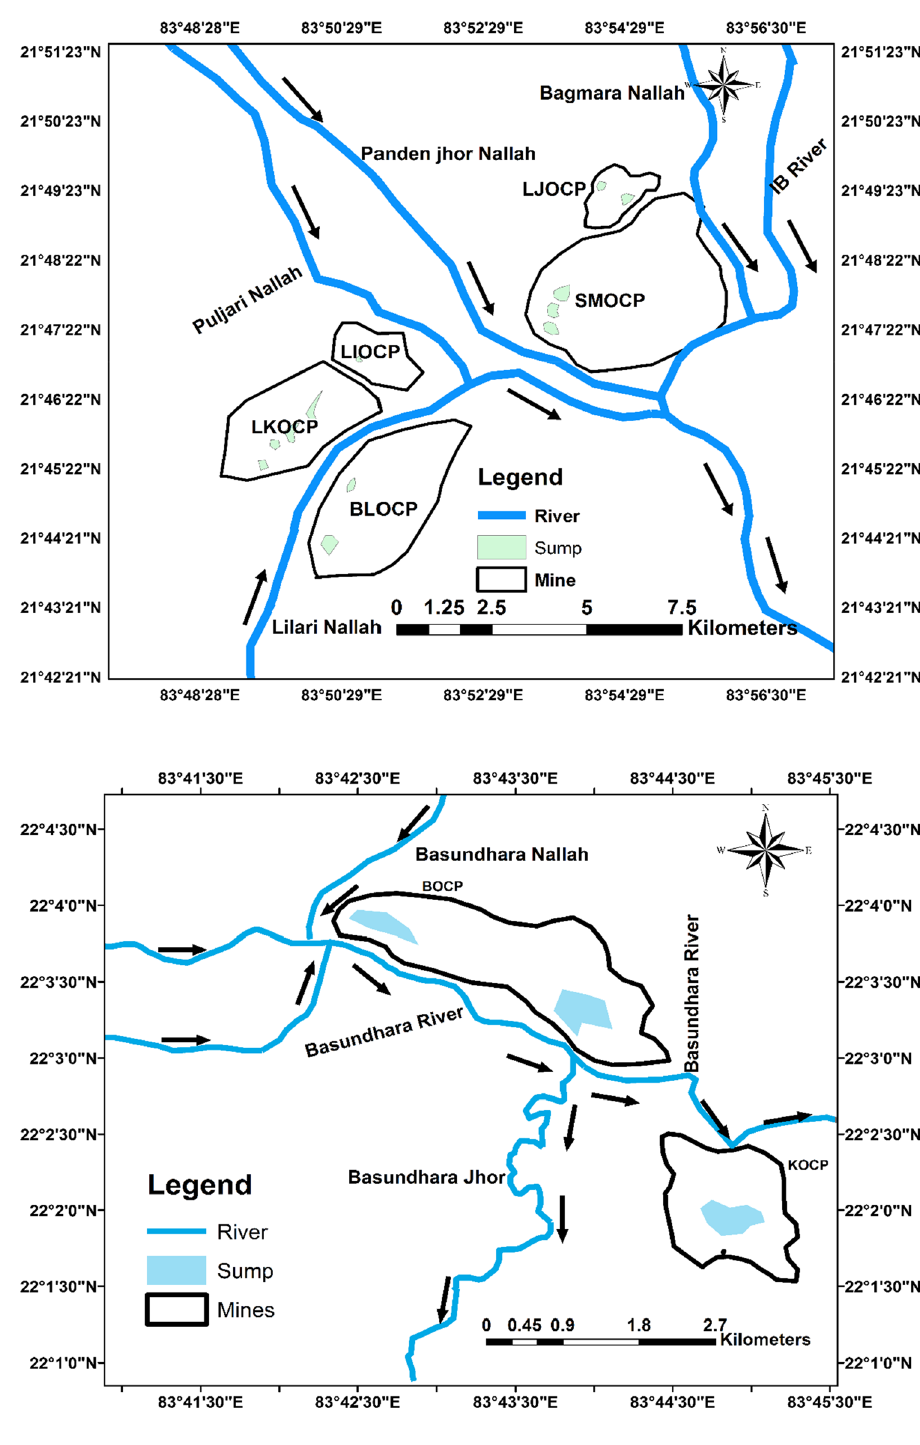
Fig. 2 Drainage pattern in Ib valley area